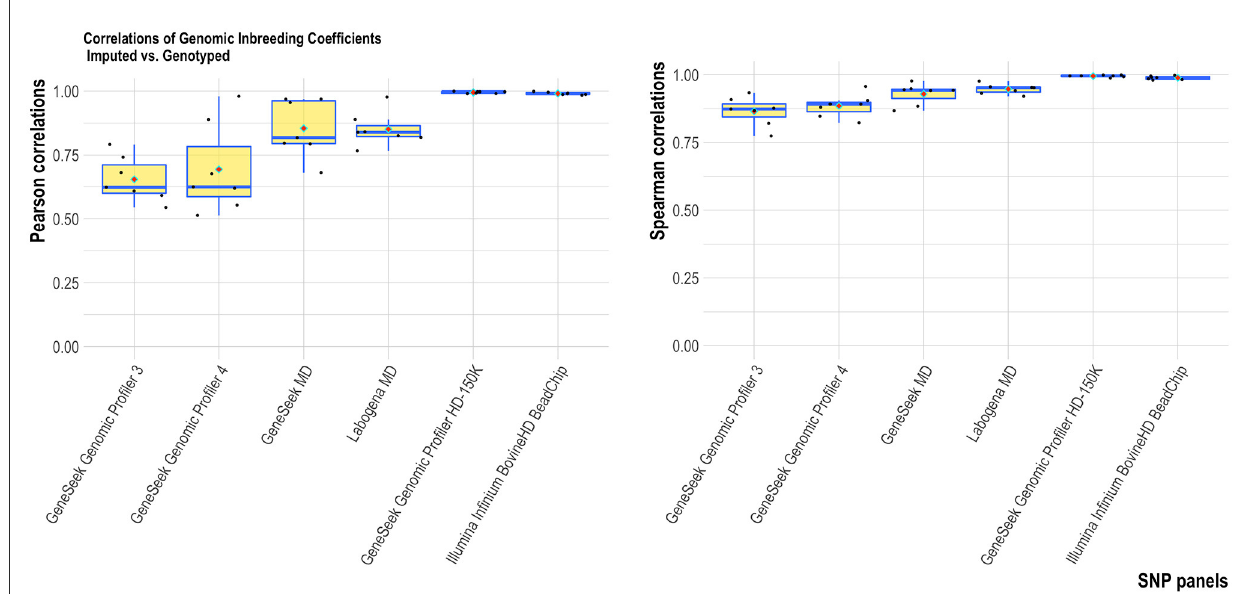
FIGURE3 Average Pearson (left) and Spearman (right) correlations of the genomic inbreeding estimators tested for each SNP panel. Horizontal bars within each boxplot represent the median, and red rhombus the mean.